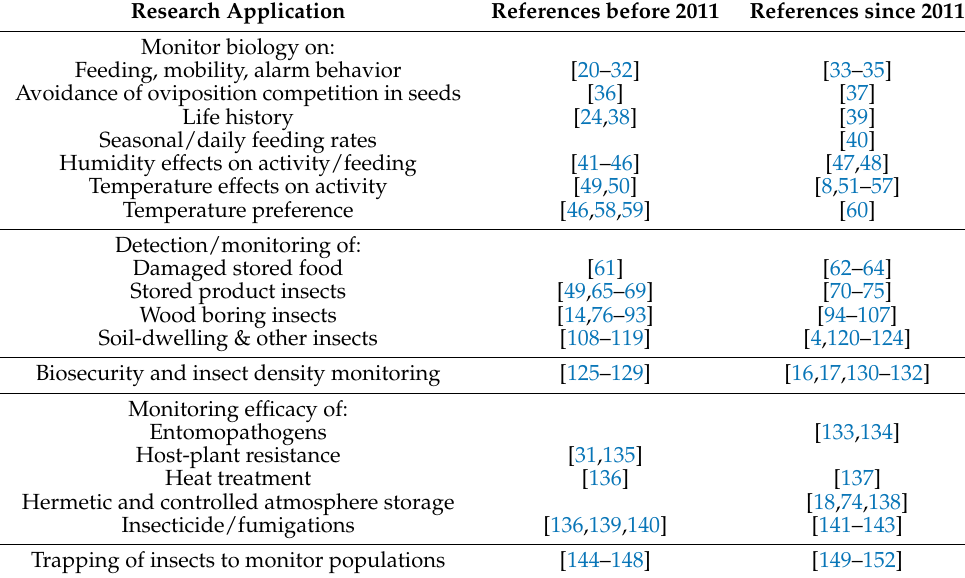
Table 2. Examples of different early and recent insect acoustic detection